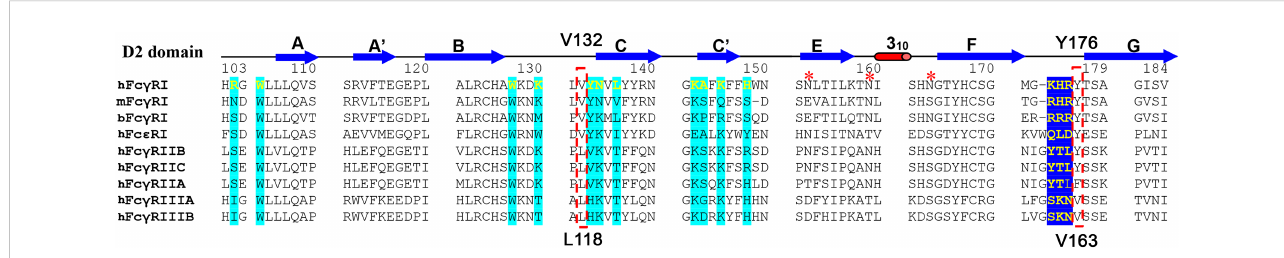
FIGURE 3 Sequence alignment of Fc g R D2 domains. The interface residues in Fc g RI-Fc complex are shaded in cyan or blue. V132 and Y176 of Fc g RI are highlighted in the red box. They correspond to L118 and V163 in Fc g RIII.